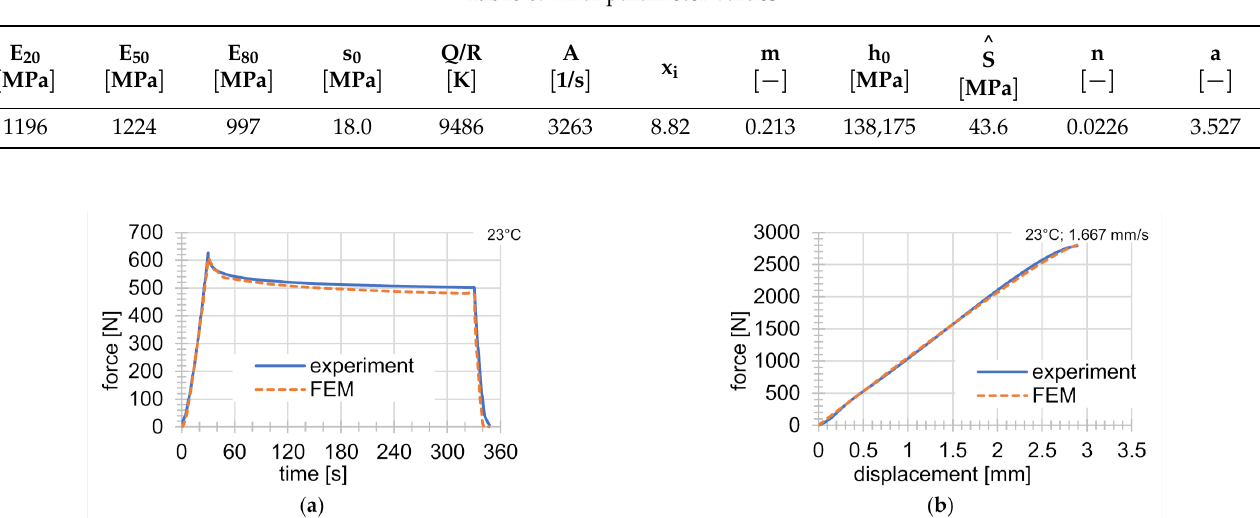
Table 6. Final parameter values.